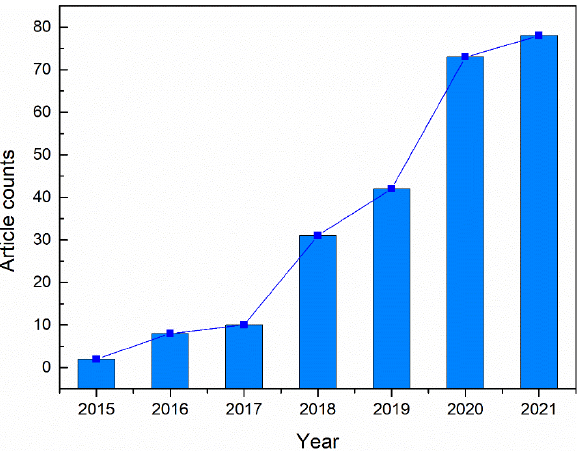
Figure 2. Number of articles about L-PBF spattering since 2016 (Topic: [“laser-powder bed fusion” and “spatter”] or [“selective laser melting” and “spatter”]) Database: Web of Science.